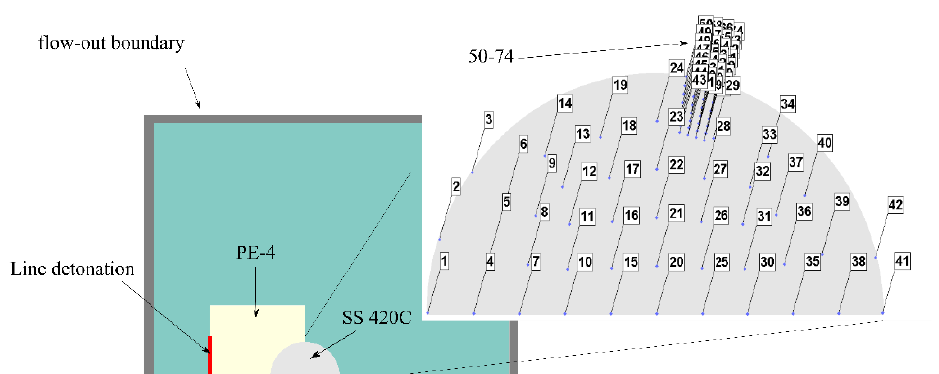
Fig. 2 Schematics of the simulations (not-to-scale) showing (a) the IED experimental arrangement, (b) a zoomed in section of the ball bearing defining the location of the gauges.